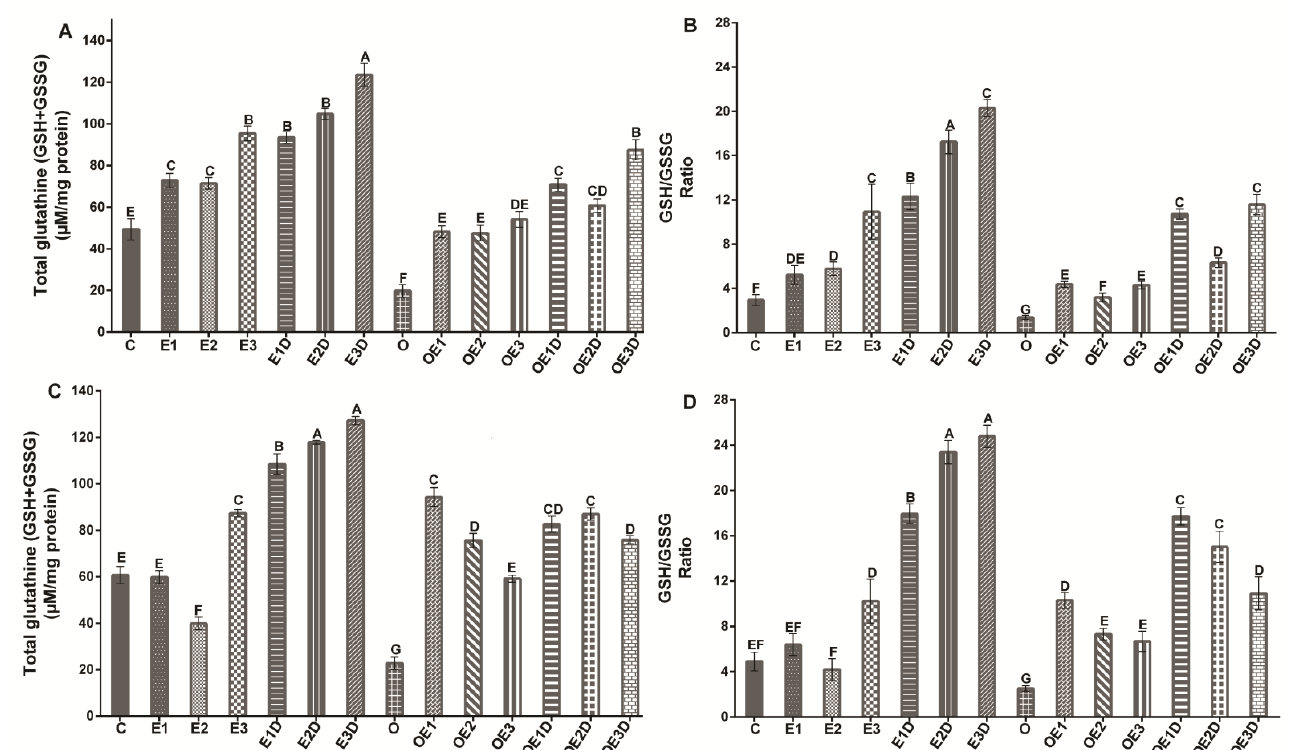
Figure 4. Effect of different exercise intensities and diazoxide on the glutathione redox state of skeletal muscle in obese rats. ( A ) Total glutathione soleus muscle, ( B ) Ratio soleus muscle, ( C ) Total glutathione EDL muscle, ( D ) Ratio EDL muscle, C: control; D: diazoxide; E1: low-intensity exercise; E2: moderate-intensity exercise; E3: high-intensity exercise; E1D: low-intensity diazoxide exercise; E2D: exercise with moderate intensity diazoxide; E3D: exercise with high-intensity diazoxide; O: obese; OD: obese diazoxide; OE1: low-intensity exercise for obesity; OE2: obese moderate-intensity exerciser; OE3: obesity due to high-intensity exercise; OE1D: low-intensity exercise diazoxide in obesity; OE2D: moderate-intensity exercise for obesity; OE3D: high-intensity diazoxide exercise for obese. Data are represented as mean ± standard error. Different letters indicate statistically significant differences between groups ( p < 0.05) 1-way ANOVA, Tukey ’ s posthoc test, n = 6.